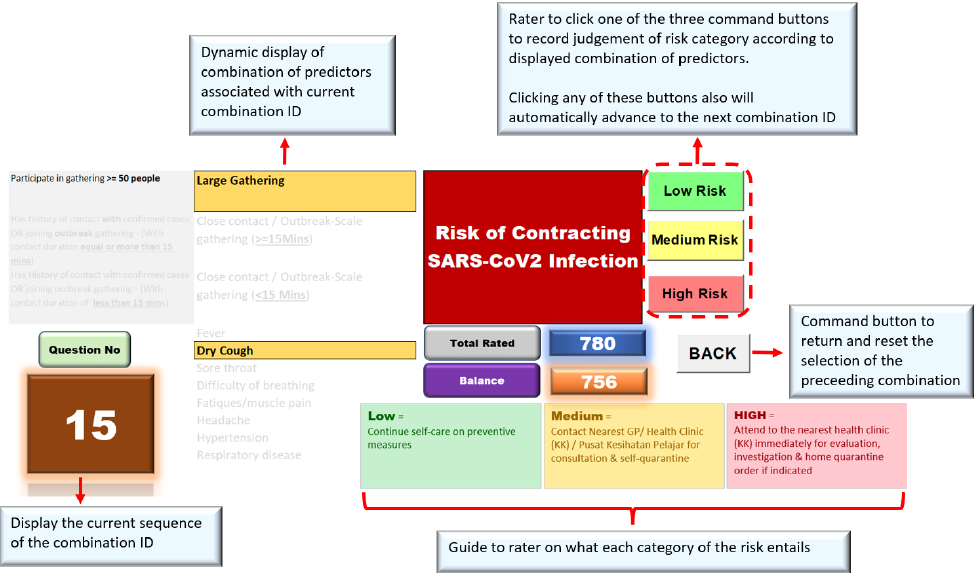
Figure 6. The final layout of the dashboard-based rating. The Algorithm-Derived Deduction of